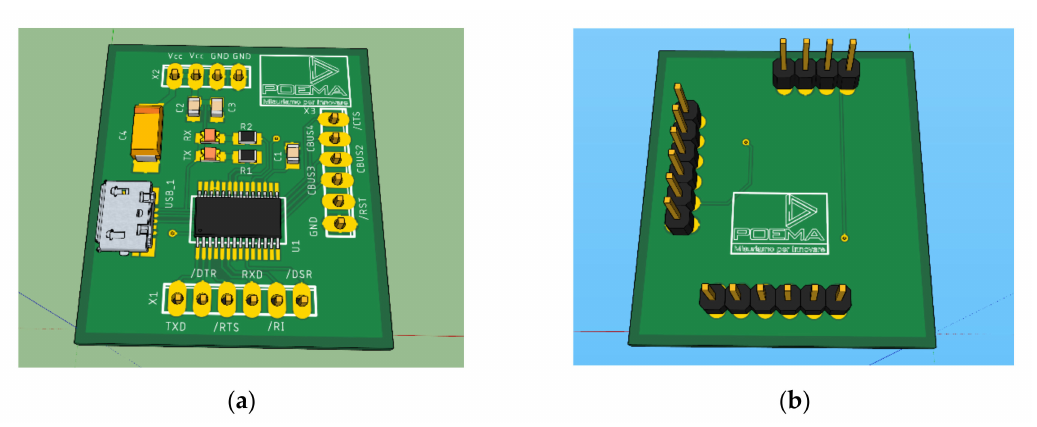
Figure 8. A 3D view of the USB module: ( a ) front side; ( b ) back side. Table 6. Main features of the FT232R chip used in the USB